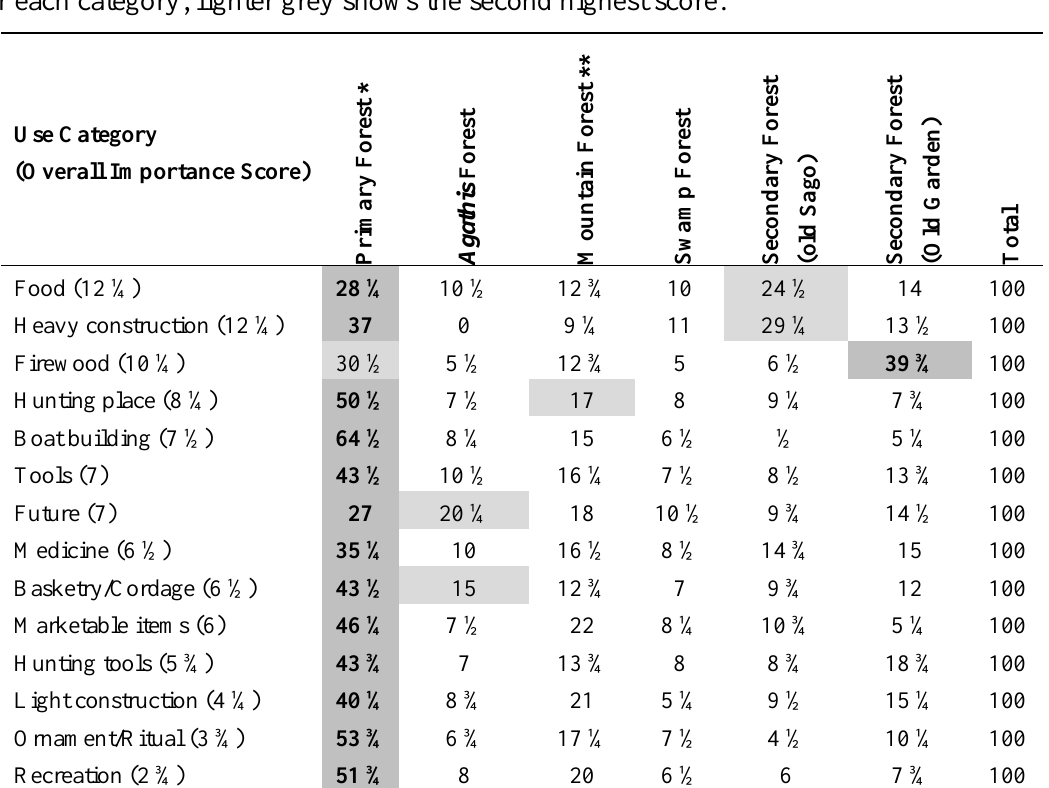
Table 3. The importance of different forest types for each respective use category. Combined scores of four PDM groups. Grey highlighted and bold are the highest scoring forest types for each category, lighter grey shows the second highest